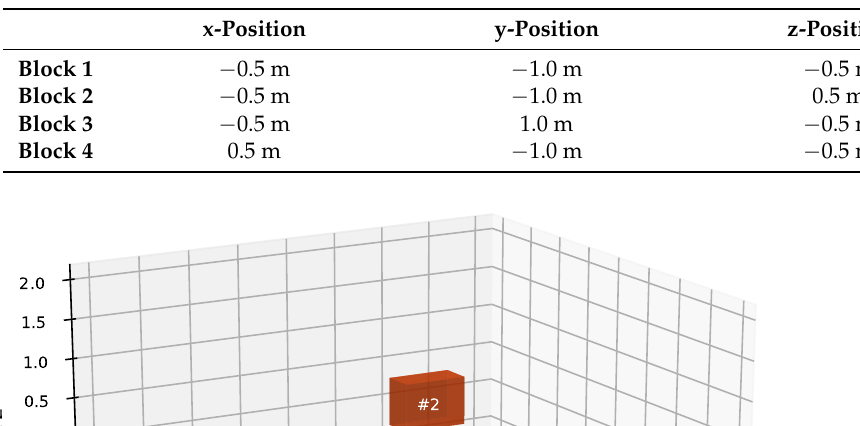
Table 2. The position of the four lead blocks.